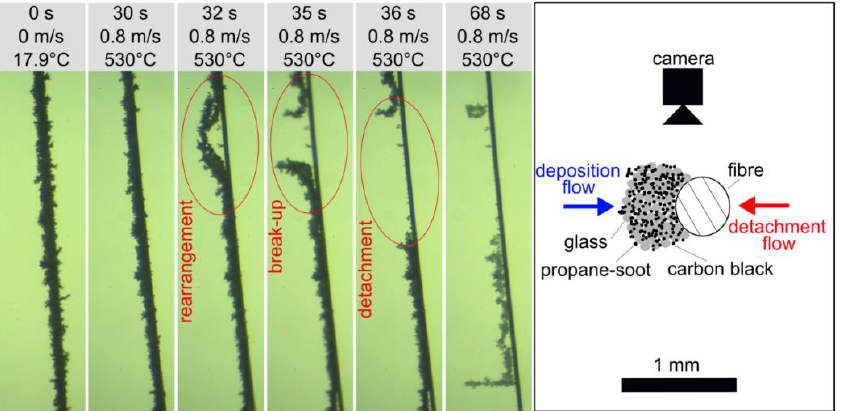
Figure 1. Detachment of particle structures consisting of propane-soot (volume median diameter 𝑥 50,3 = 0.352 µm), carbon black ( 𝑥 50,3 = 0.445 µm) and glass spheres ( 𝑥 50,3 = 6.8 µm) from a single 40 µm steel fibre in hot air flow with an average flow velocity of 0.8 m/s at 530 °C. This experiment